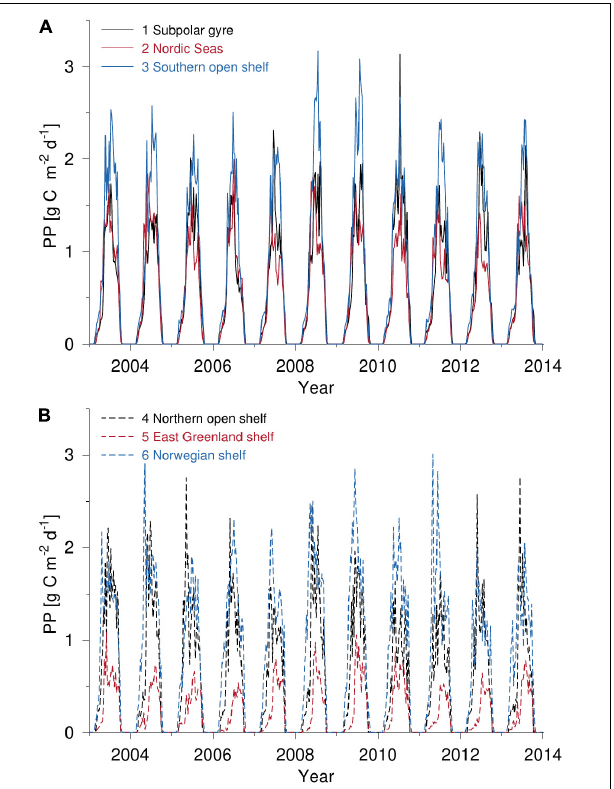
FIGURE 3 | PP calculated by the VPP-model during the 2003–2013 period for (A) subdomains 1–3 and (B) 4–6.